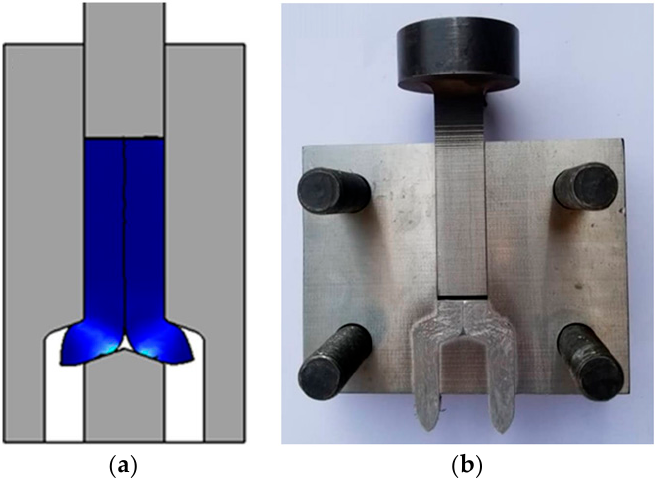
Figure 16. ( a ) Finite element method and ( b ) the geometry of the deformed billets in the TPCAE method [85].